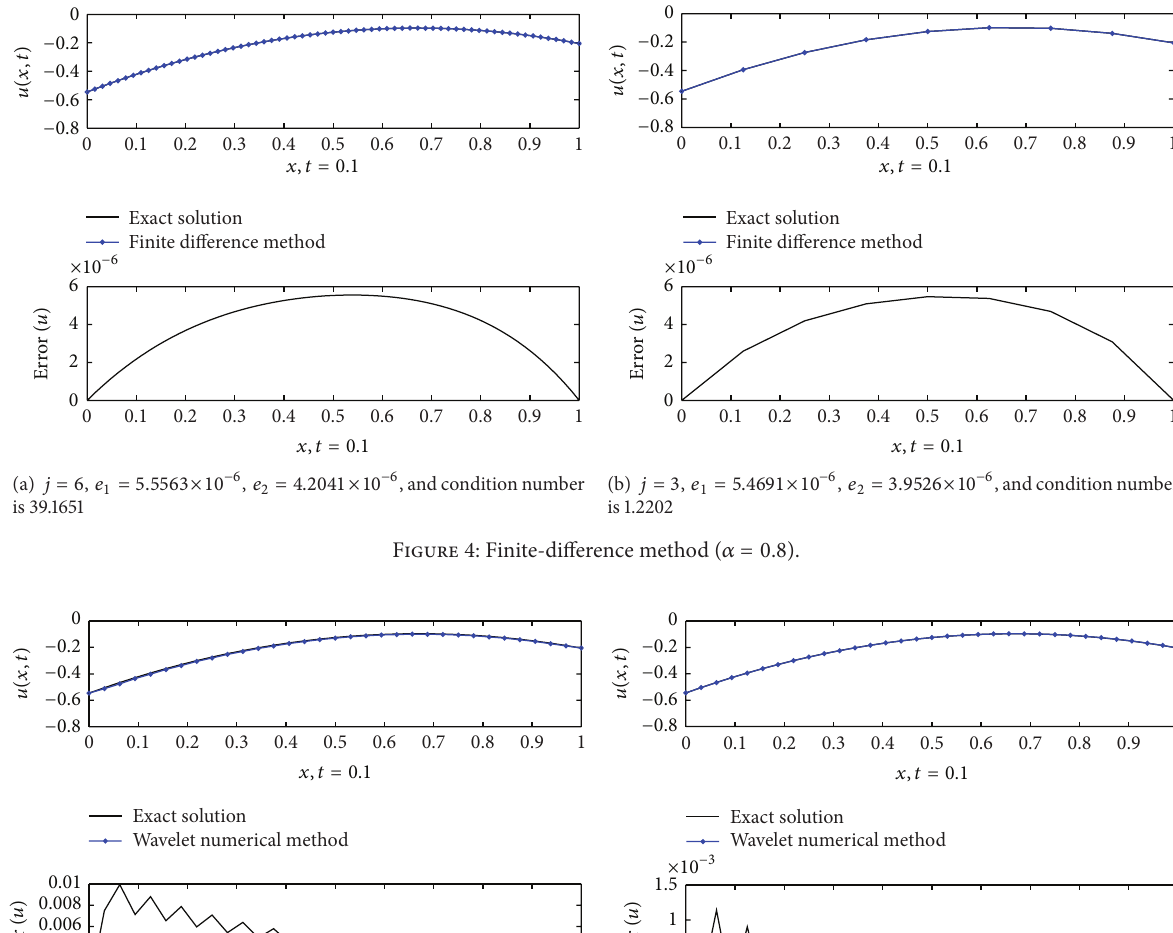
Figure 5: Comparison between the static and dynamic interval Shannon wavelet collocation method ( 𝛼 = 0.8